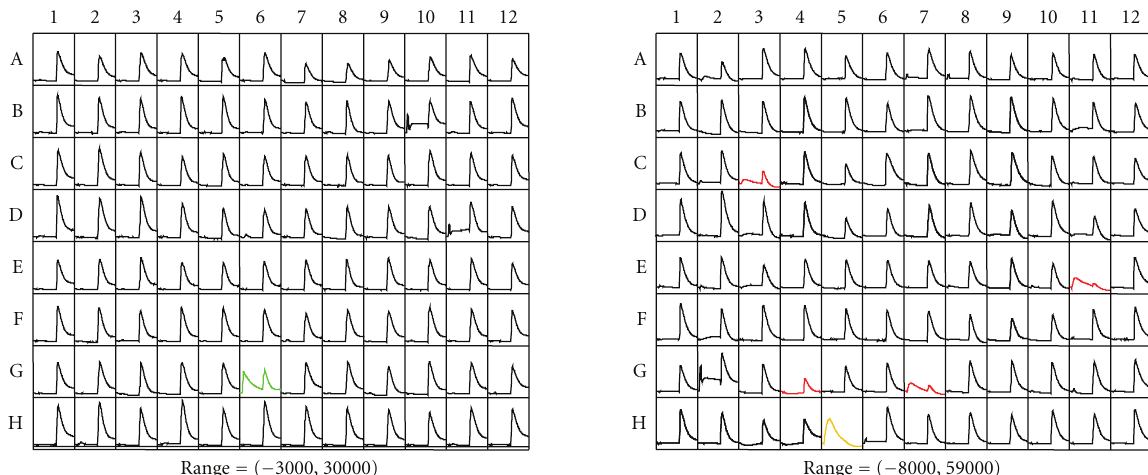
Figure 4: Representative FLIPR traces obtained from LOPAC screen. Compounds from the LOPAC library were applied followed by the addition of beta-alanine. Similar responses were observed for human and rat MrgD cell lines. Parental CHO-DUKX cell lines were also tested to identify nonspecific e ff ects of test compounds. Green, red, and yellow traces represent agonist, antagonist, and nonspecific traces, respectively.